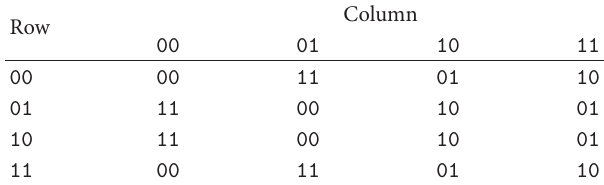
Table 4: The decomposed RT and CT arrangement.